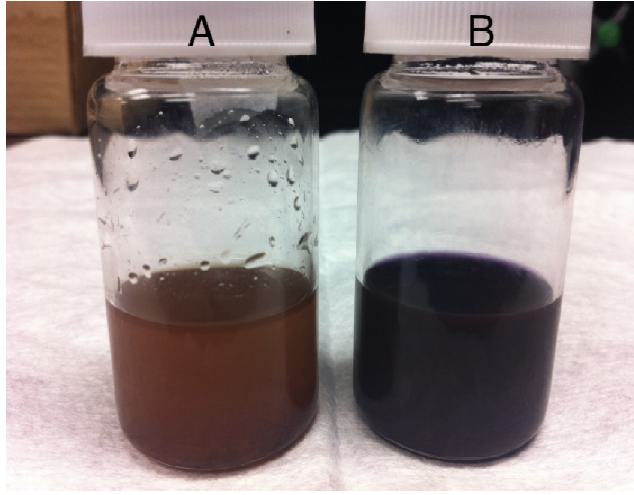
Figure 20. Photographs of ( A ) Au-pure aniline colloids after digestive ripening 2 h; and ( B ) the Au-pure aniline colloids that was ripened for 7